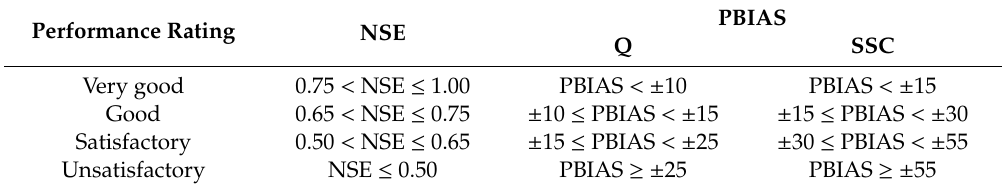
Table 3. General Performance Ratings for NSE and PBIAS of a Monthly Time Scale